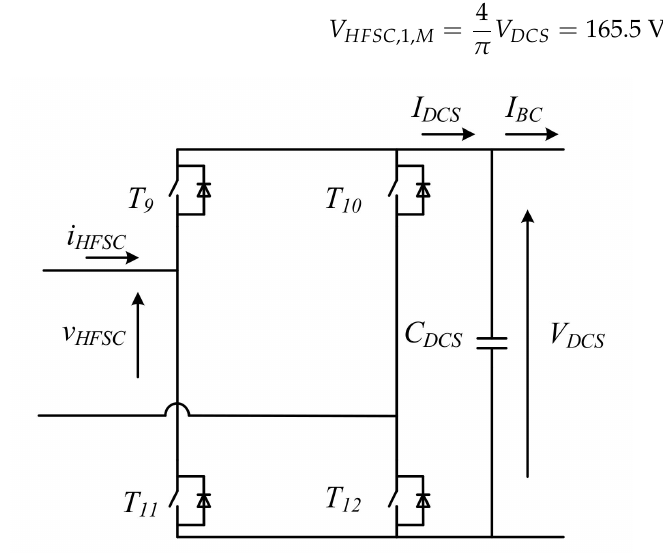
Figure 9. Schematics of the HFSC and convention of the current according to charging